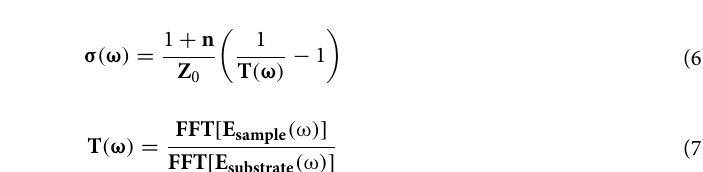
Figure 5. Time-domain terahertz spectroscopy set-up. ( a ) Pictorial view of Time-domain terahertz spectroscopy system and insets show the arrangement of parabolic mirrors and sample holder. ( b ) Schematic representation of THz-TDS